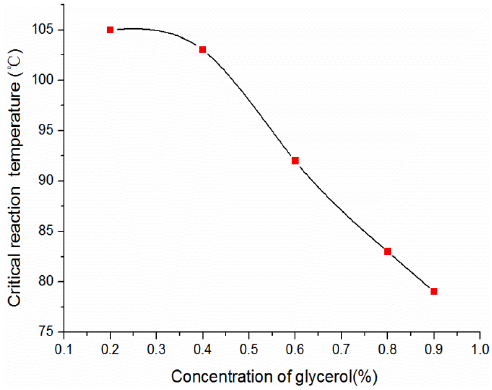
Figure 14. The critical reaction temperature in different glycerol concentrations.